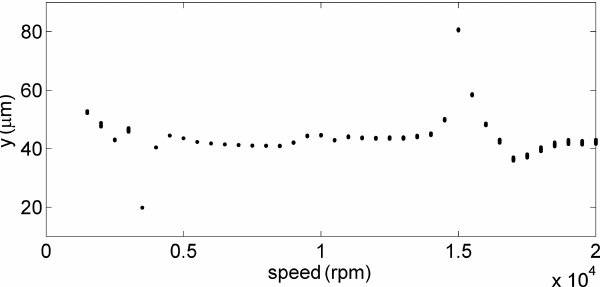
Figure 8. Bifurcation at the torque load of 5000Nm and the lubri- cating oil viscosity of